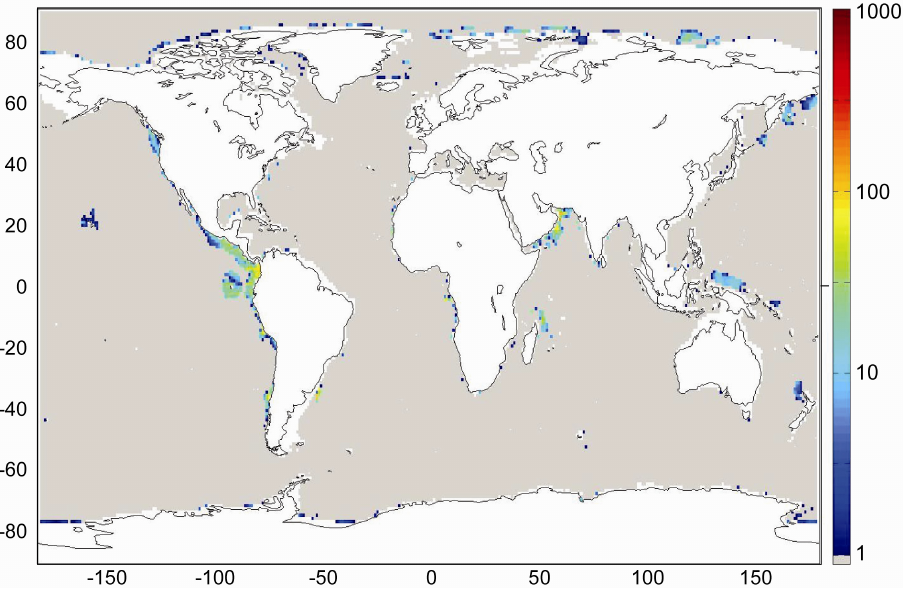
Figure 30. Global distribution of methane hydrate in marine sediments. The map was calculated applying low compaction [Equation (31)] and Quaternary burial velocities. The color coding indicates depth-integrated hydrate inventories in kg C m − 2